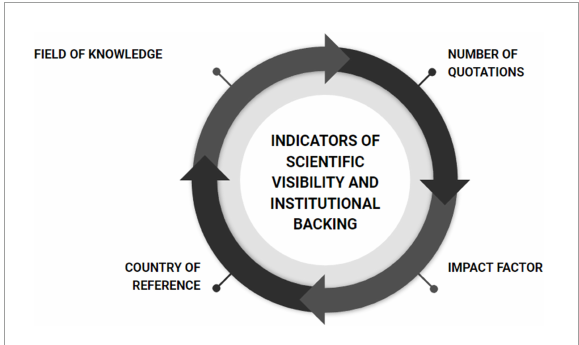
FIGURE2 Criteria for the analysis of institutional backing and the visibility achieved with the publication of an empirical study aimed at improving the functioning of the university